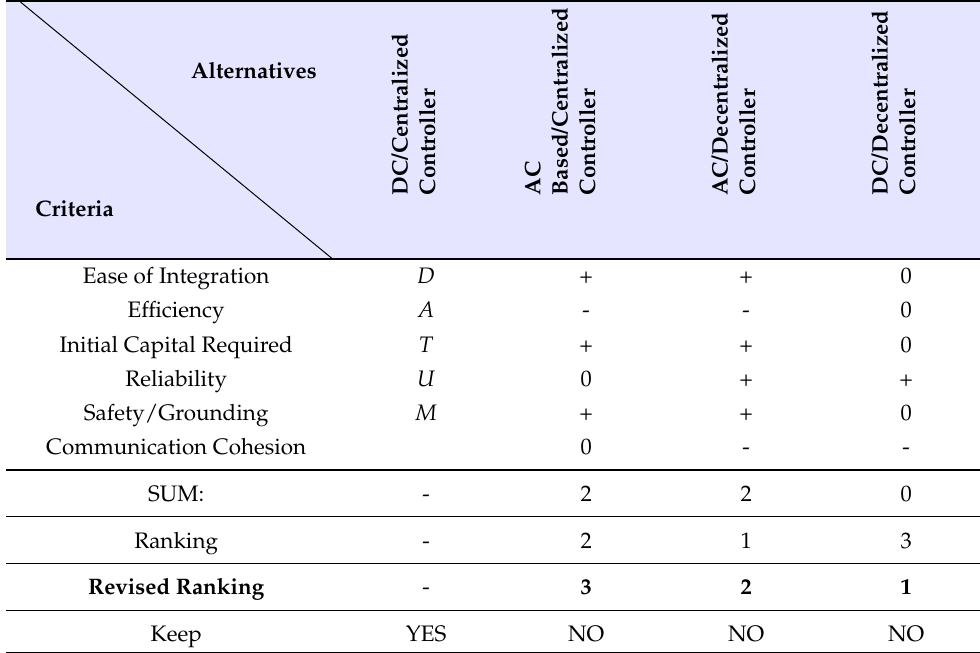
Table 4. Pugh Matrix for Nanogrid Design. The baseline (DATUM) design of the DC-based cen- tralized controller nanogrid is compared against the alternatives. The +, -, and 0 symbols indicate “better,” “worse,” and “no difference” respectively for each criteria for each of the three alternatives to the DATUM. The criteria are summed for each alternative and the DATUM; this provides a ranking which a base energy manager can use to inform a final decision (the “revised ranking”). In the case study, while the ranking indicates the AC-Based/Centralized Controller is most preferred, the base energy manager has decided to overrule the ranking and instead has indicated preference for the DC/Decentralized Controller due to survivability